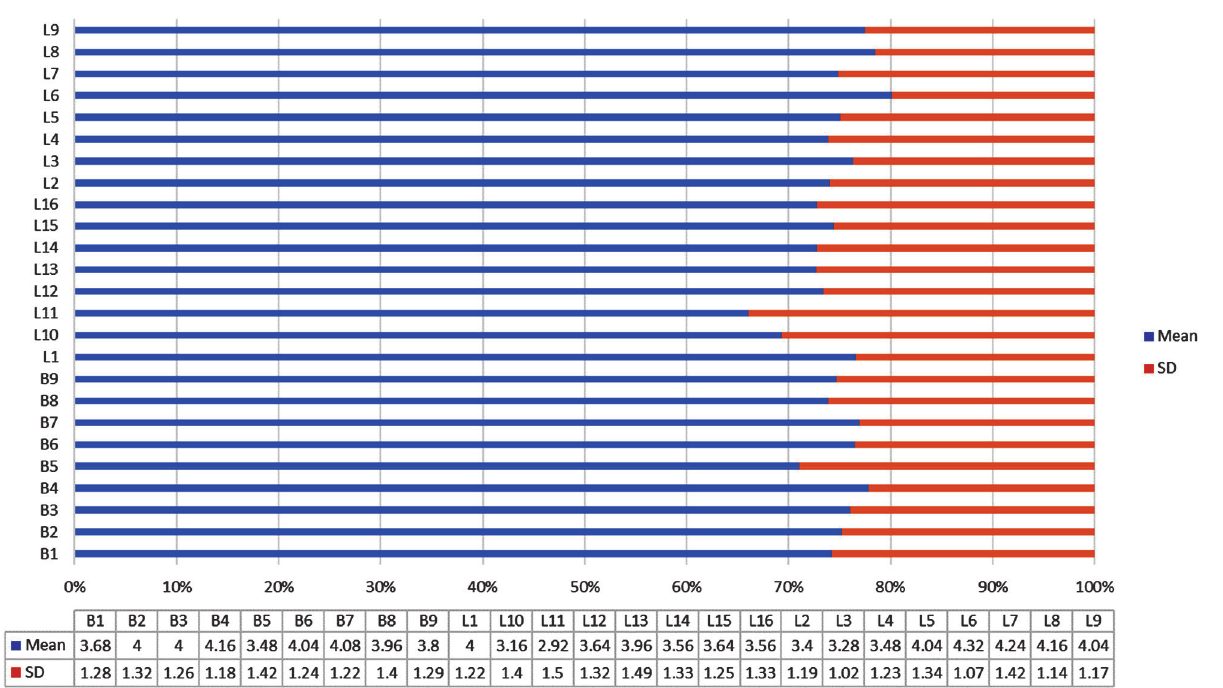
Figure 5. Descriptive results of most relevant BIM functionalities and Lean